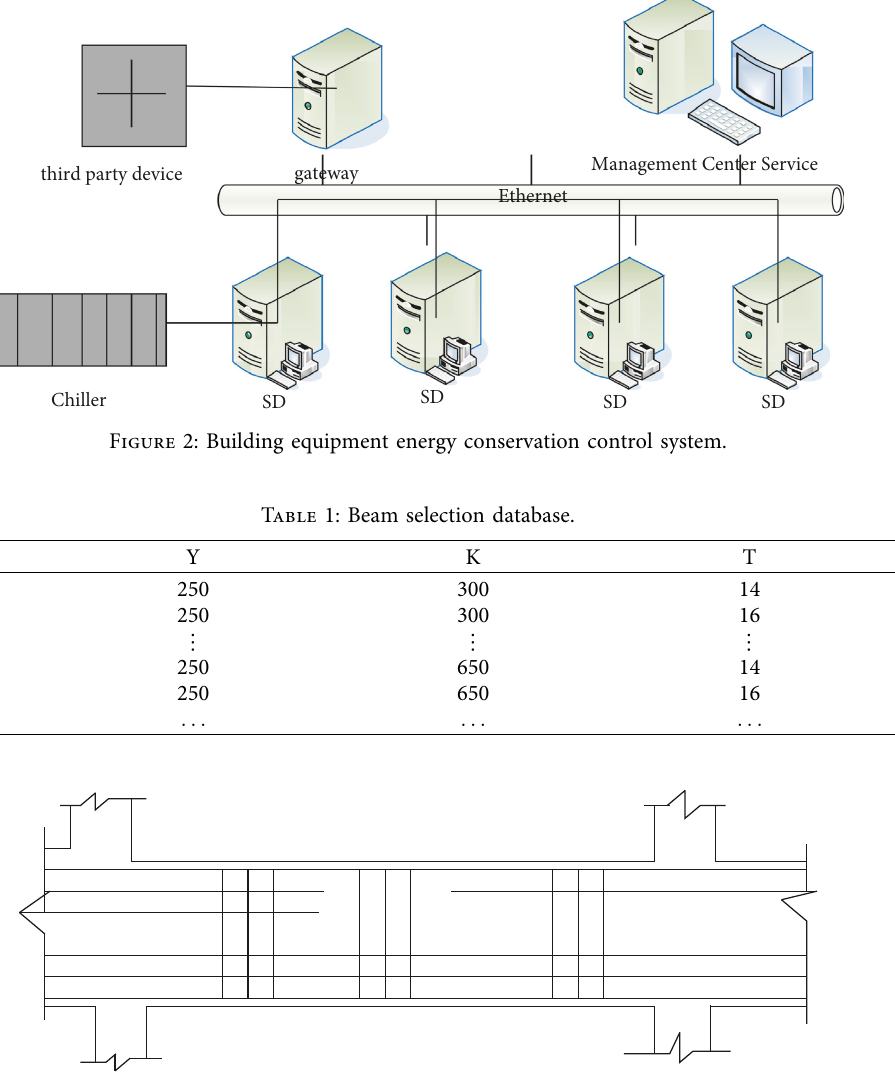
Figure 3: Model of beam